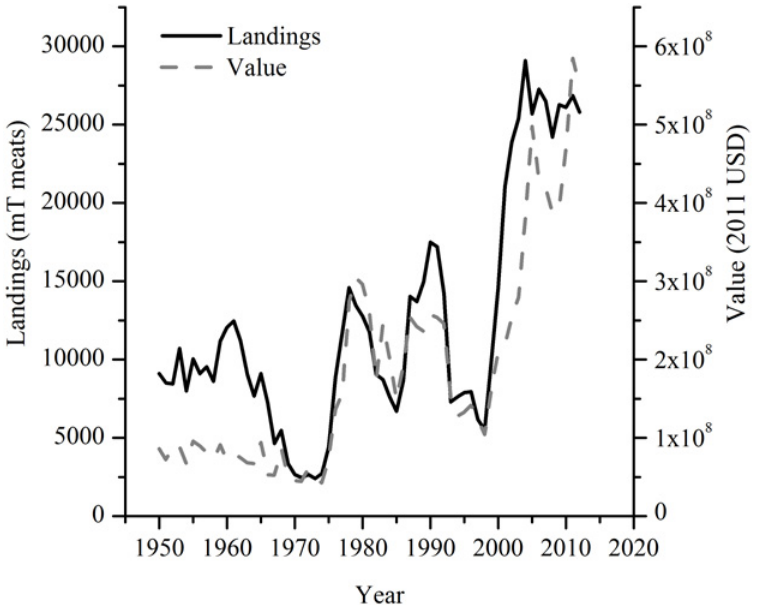
Fig 1. US sea scallop harvests through time (NMFS commercial harvest data accessed January 28, 2014). Values are adjusted to 2011 US